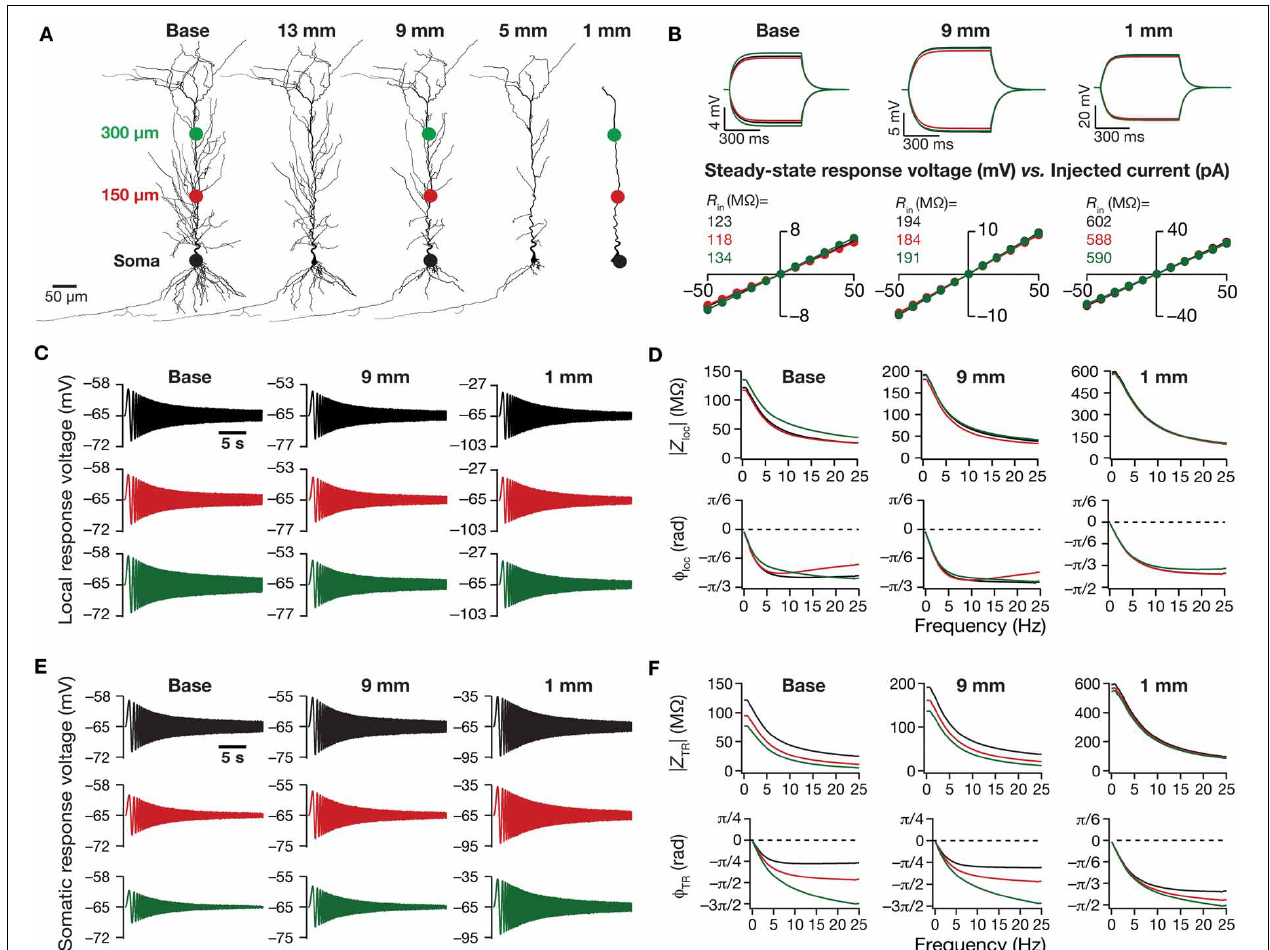
FIGURE 1 | Traces and measurements related to neuronal intrinsic response dynamics revealed significant somatodendritic changes with dendritic atrophy in a passive neuronal model. (A) Baseline and a subset of pruned morphologies employed in this study. Base: two-dimensional projection of a CA1 pyramidal neuron reconstruction. The total dendritic length of the neuron was 17.5, 13, 9, 5, and 1mm are the labels provided for atrophied dendritic reconstruction, and correspond to the total dendritic length of these pruned morphologies. The three colored dots along the trunk marked at the soma (black), and at ∼ 150 μ m (red) and ∼ 300 μ m (green) away from soma depict the color-coded locations corresponding to the traces and plots shown across all figures of the manuscript. The markings are shown only on dendritic trees where traces/analyses are elaborated in (B–F) . (B) Local voltage traces (top) and steady-state V – I plots (bottom) fitted with straight lines obtained in